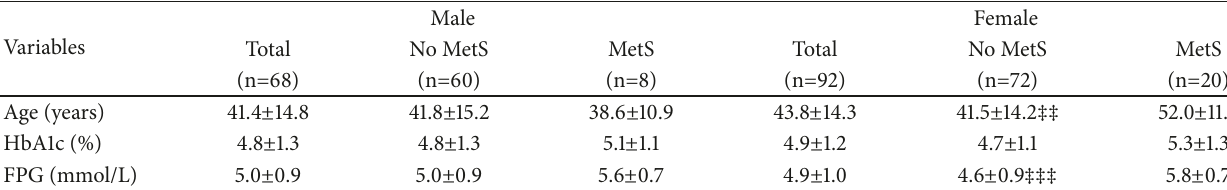
Table 2: Biochemical parameters of studied population stratified by gender.